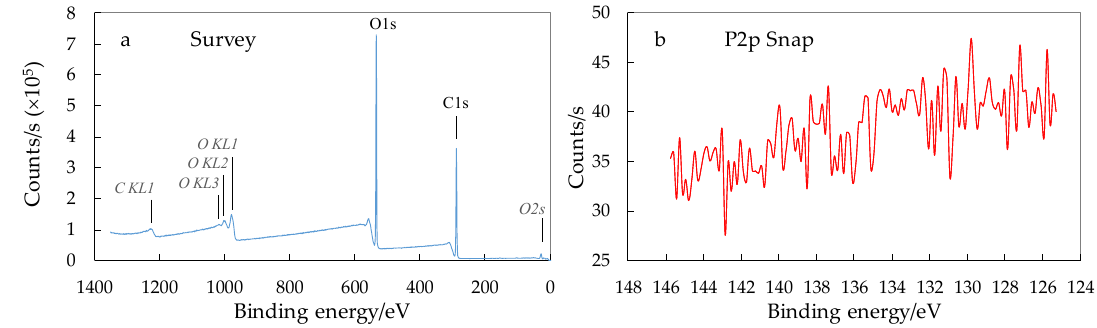
Figure 4. XPS spectra of CNC_P76: ( a ) XPS wide scan patterns; ( b ) XPS spectra in the range of binding energies of P 2p peak.